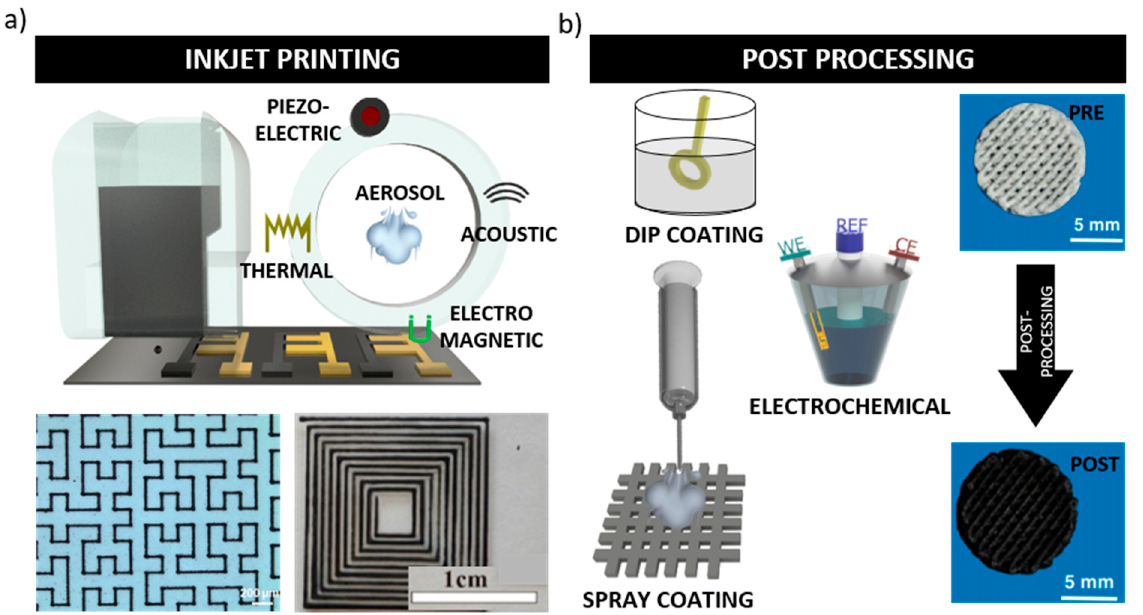
Figure 3. 3D printing methods used for 2D materials. ( a ) Inkjet printing, which uses the inputs as piezoelectric to forms droplets that are deposited on the surface. Two examples are shown: Ti 3 C 2 Tx MXene formulated with PEG-diacrylate for aerosol printing (bottom left) and PEDOT: PSS/MoS 2 patters printed by inkjet printing used for high-performance supercapacitors (bottom right). Reprinted with permission from ref. [83], ref. [85] and ref. [86]. Copyright 2021 American Chemical Society and 2020 Elsevier, respectively. ( b ) Post processing of previously printed 3D structures throughout electrochemical, dip, and spray coating with the targeted 2D material. Blue back images: three-dimensional (3D) with a MoS 2 hydrothermally incorporated at 180 °C using MoO 42 − as precursor. Figure adapted and reprinted with permission from ref. [93]. Copyright 2017 Springer Nature under Creative Commons.